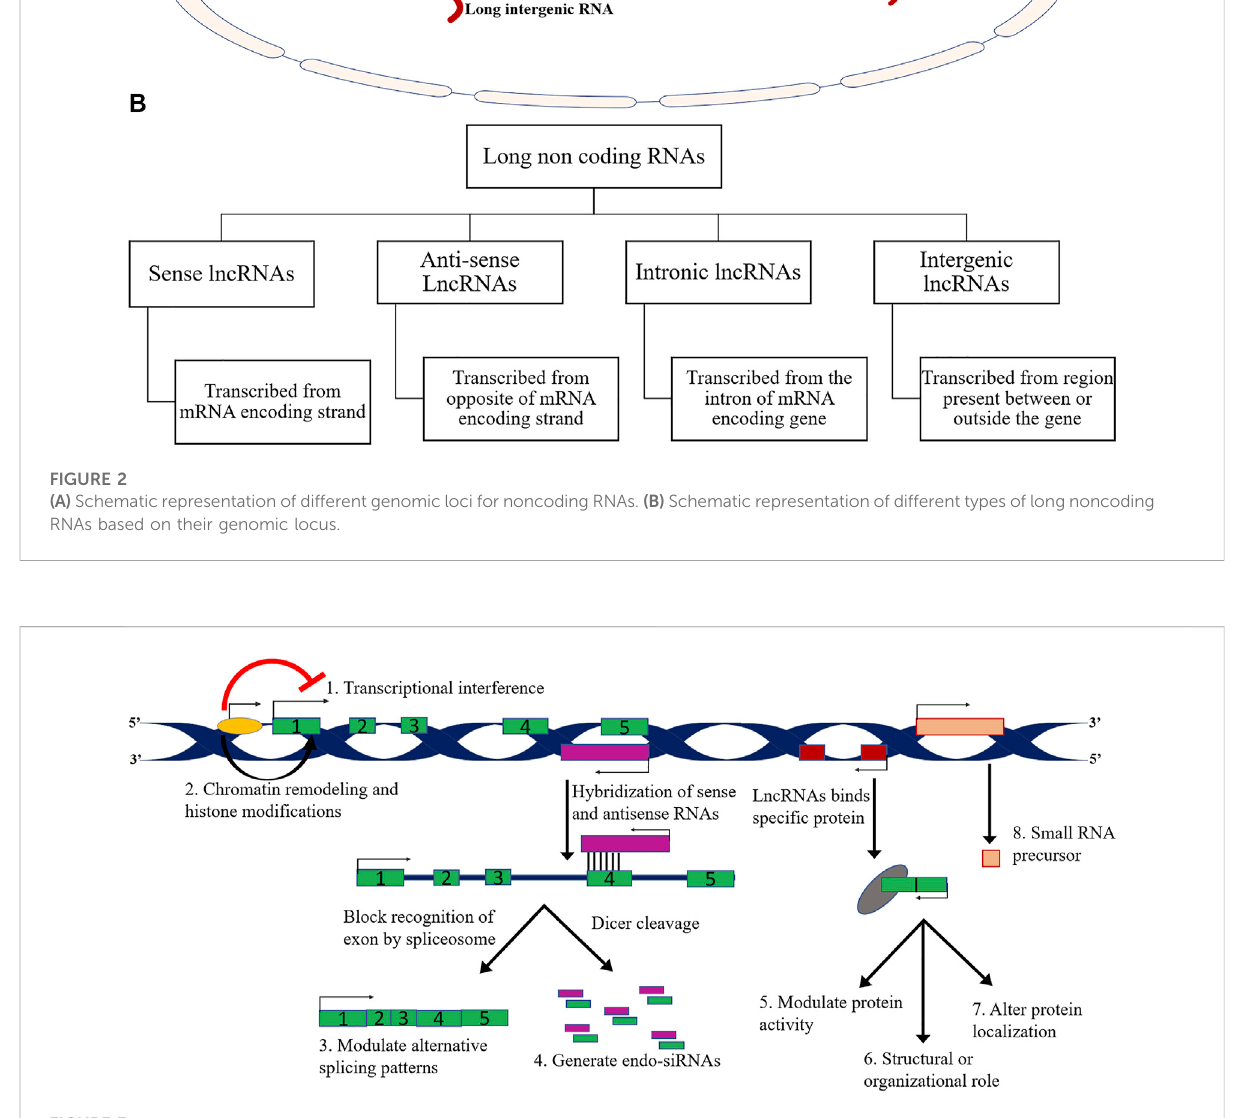
FIGURE 3 Schematic representation of different types of long noncoding RNAs based on their